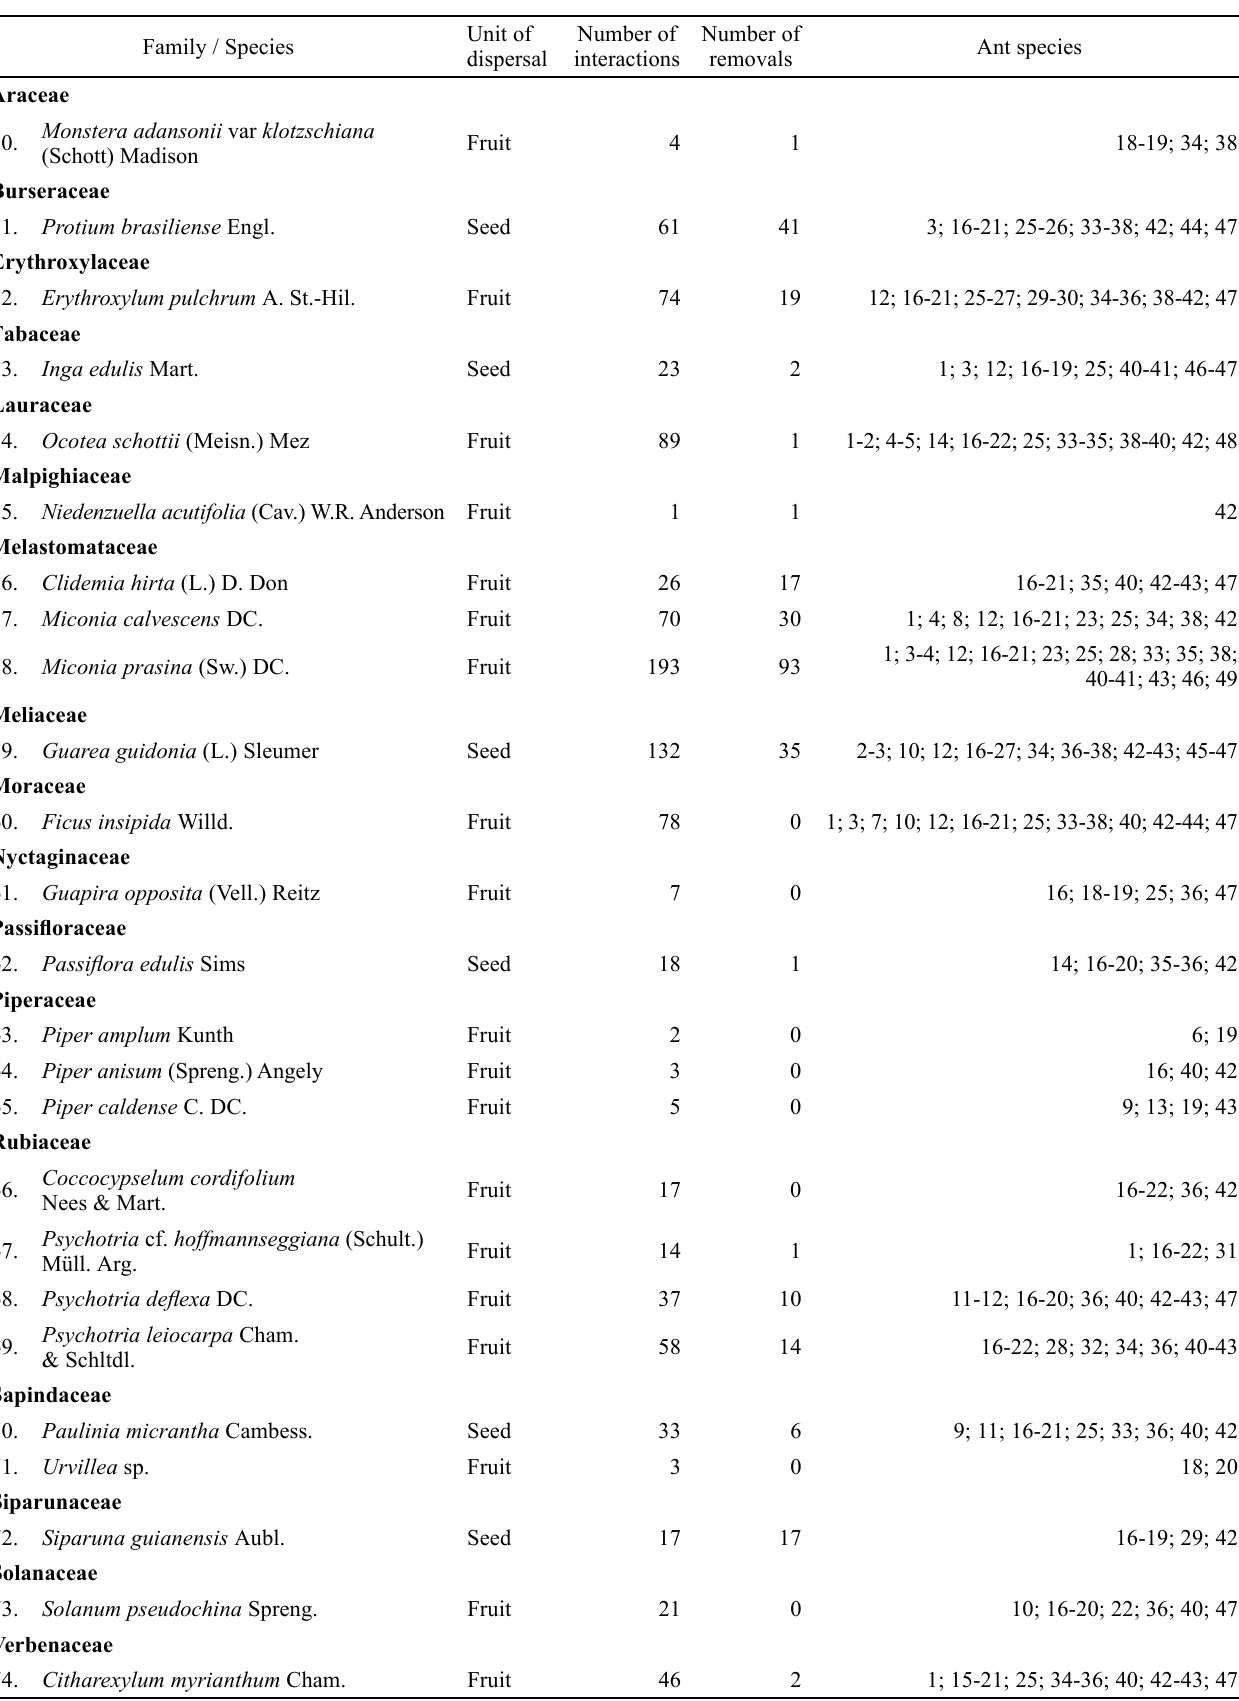
Table 3 . Diaspore species explored by ants in this study on Marambaia Island (RJ) with the total number of interactions recorded and ant species with which they interacted (see code in Table